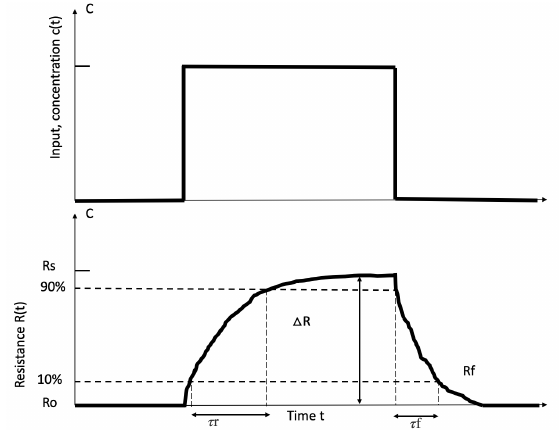
Figure 5. Typical Response of a Chemical Gas Sensor